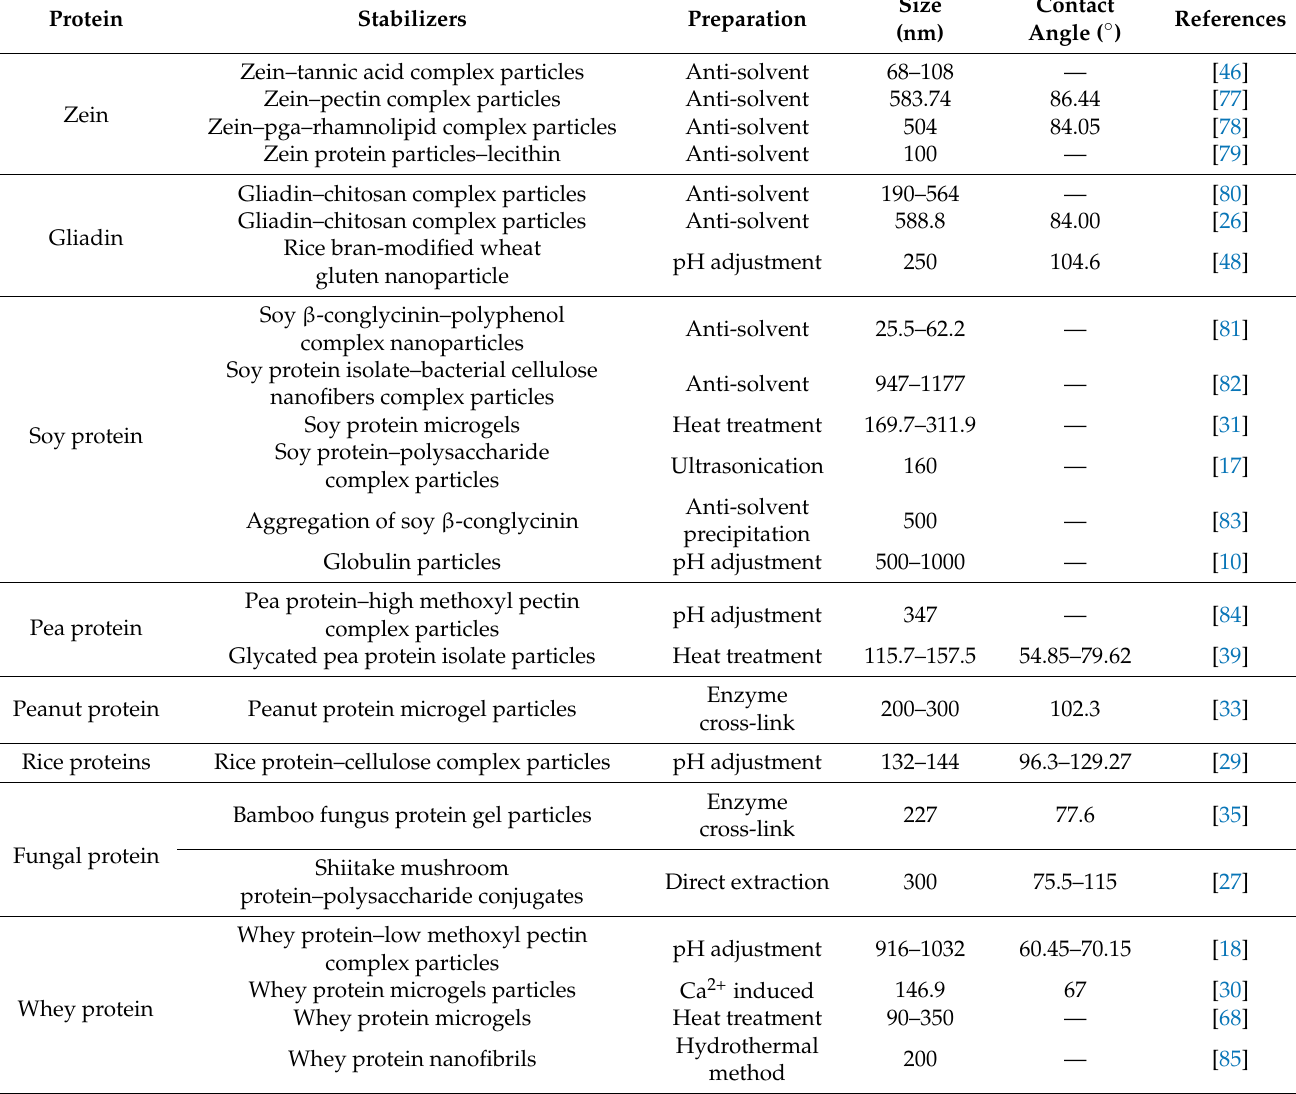
Table 1. Sources, composition, fabrication and characteristics of protein